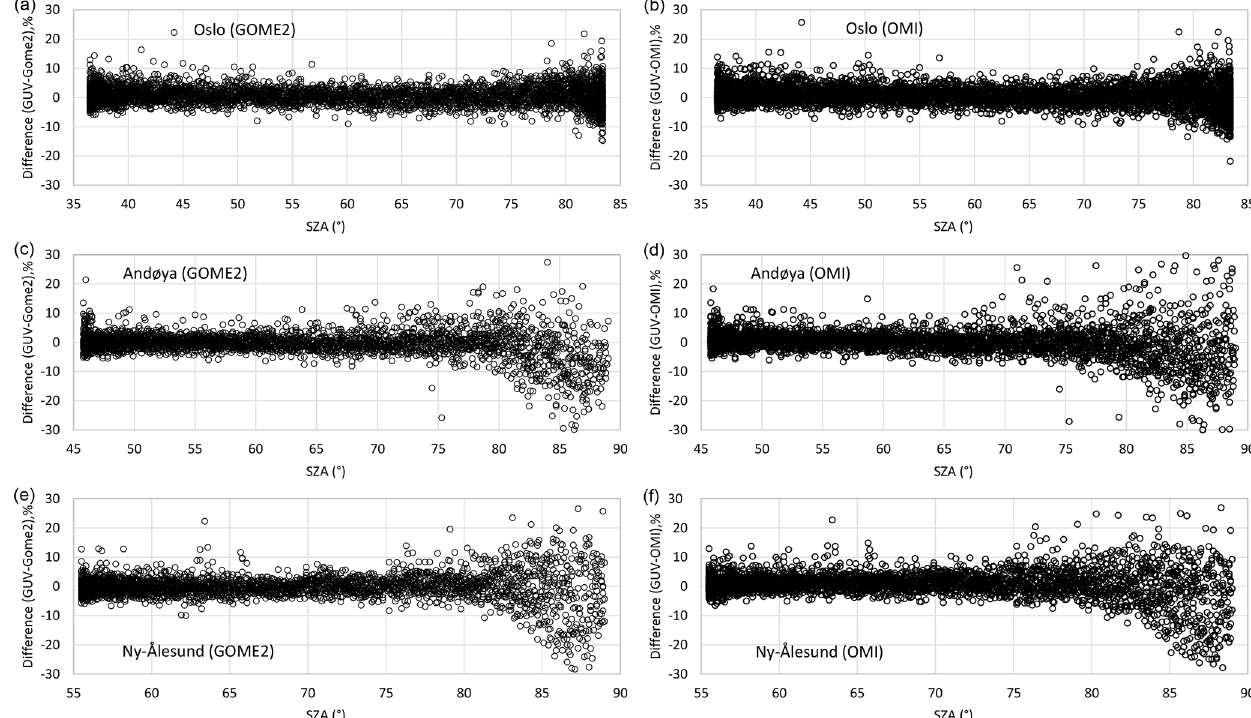
Figure 7. Total ozone differences (in %) between GUV and GOME-2 (a, c, e) and GUV–OMI (b, d, f) : Oslo (a, b) , Andøya (c, d) , and Ny-Ålesund (e, f)